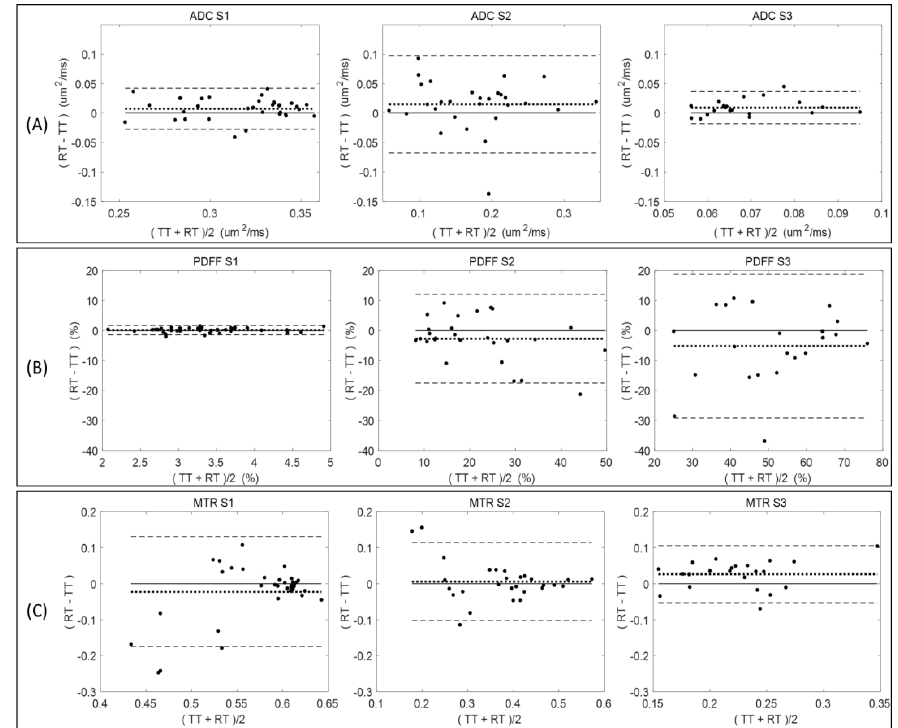
Figure 2. Bland–Altman plots graphically illustrate biomarker repeatability between paired test (TT) and retest (RT) measurements for ( A ) ADC ; ( B ) PDFF; and ( C ) MTR. Plots for sections S1, S2, and S3 are in the left, center, and right columns, respectively. Mean difference (bias) is shown as dotted lines, and dashed lines represent limits of agreement (LOA). Vertical scale is held constant for each given biomarker to illustrate section-dependent repeatability (i.e., location along tibia—see Figure 1). Refer to Table 1 for number of TT–RT pairs in each plot. Table 1. Repeatability statistics for diseased mouse tibia bone-marrow section QIBs.